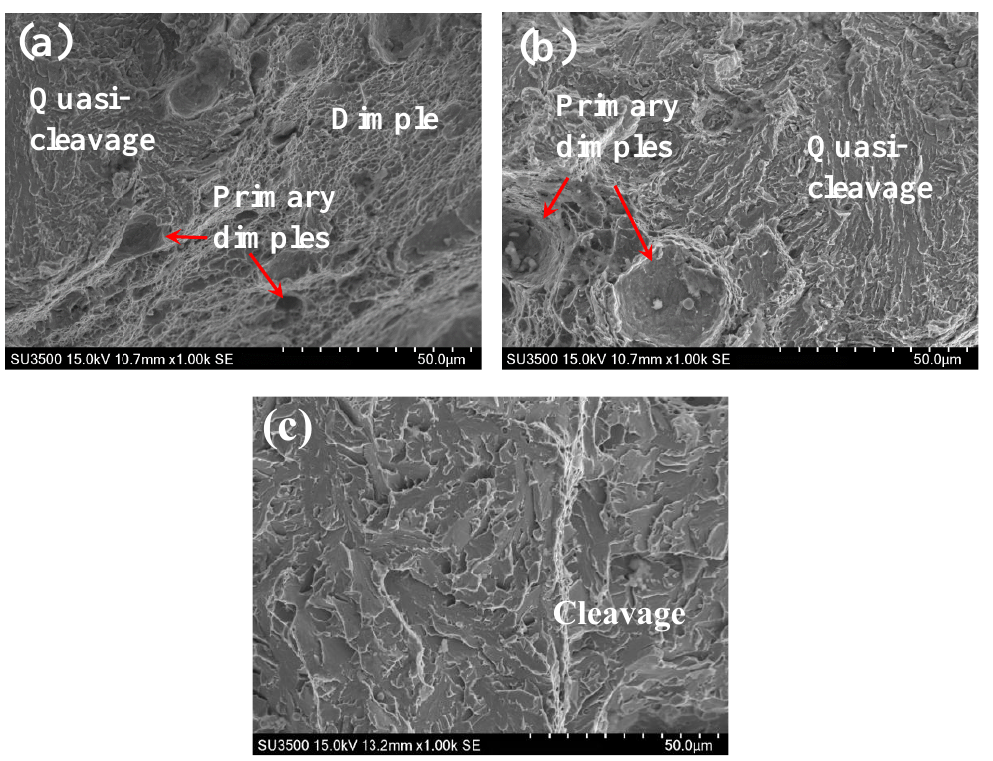
Figure 8. The microscopic fracture surface under HC condition: ( a , b ) BM and ( c ) WM. Table 2. Summary of results for the microscopic fracture surface for BM and WM specimens under HF and HC conditions.